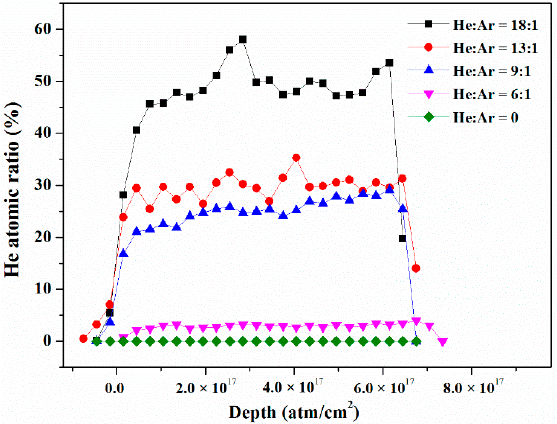
Figure 1. helium depth distribution in Er films determined by ERDA. Figure 1. Helium depth distribution in Er films determined by